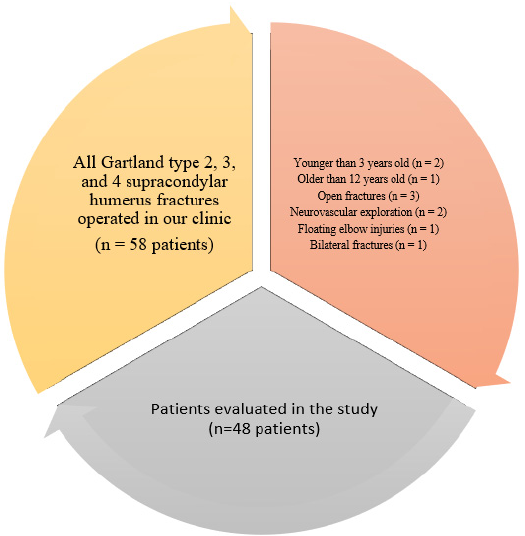
Figure 1. Detailed analysis chart of patients included and excluded from the study.